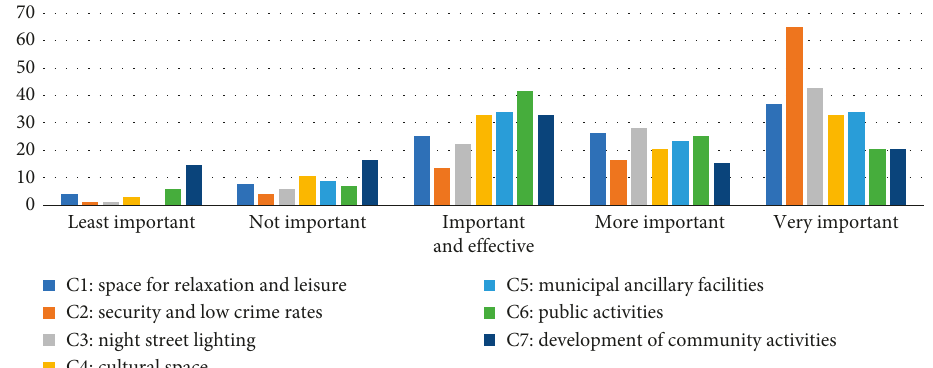
Figure 11: Evaluation of social factors.